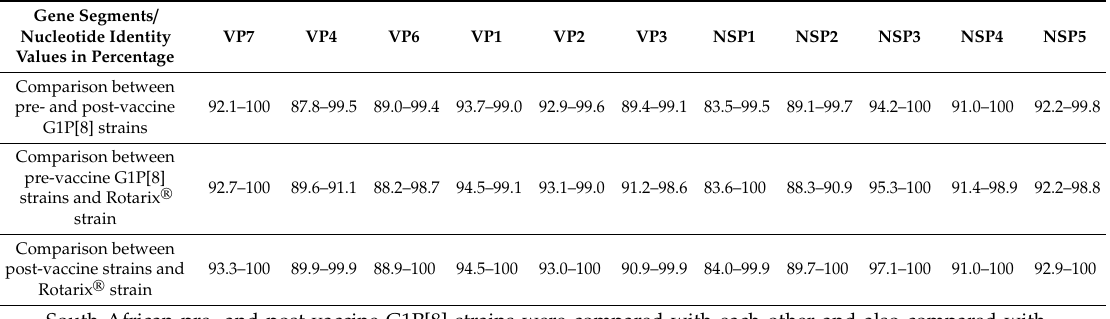
South African pre- and post-vaccine G1P[8] strains were compared with each other and also compared with the Rotarix ® strain. The nucleotide identity values were calculated using the p - distance algorithm in MEGA 6 software (S2).